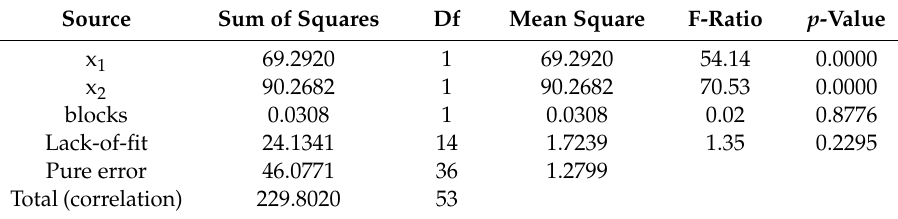
Table 3. Analysis of variance: the empirical model for predicting ethyl acetate. Source Sum of